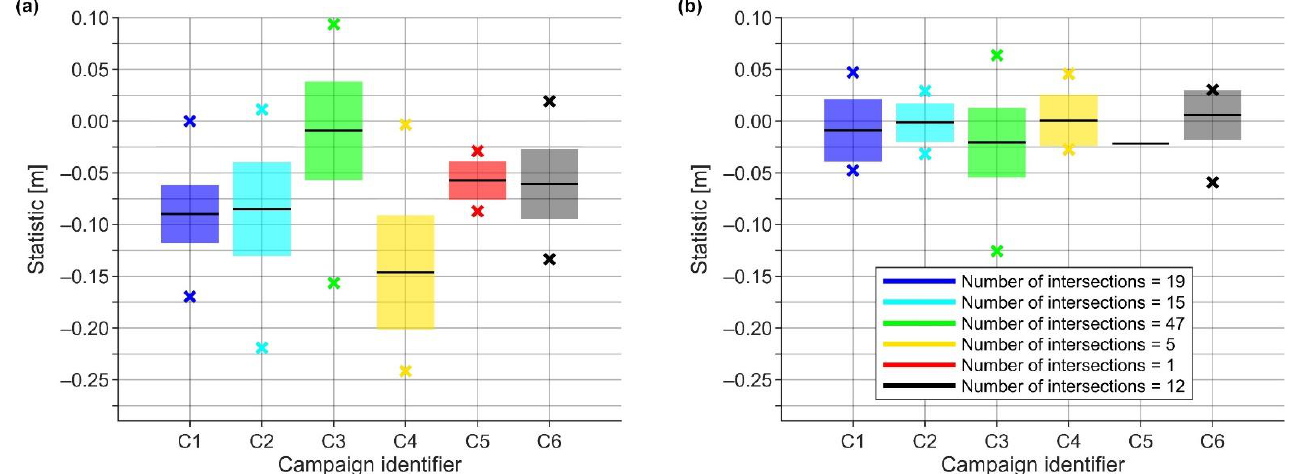
Figure 14. Statistical properties of ( a ) filtered and corrected residuals and ( b ) their differences at campaign–internal intersections. The black lines are mean values, and colored bars denote standard deviation estimates. With crosses are shown minimum and maximum residuals and their differences at intersections in ( a,b ), respectively.